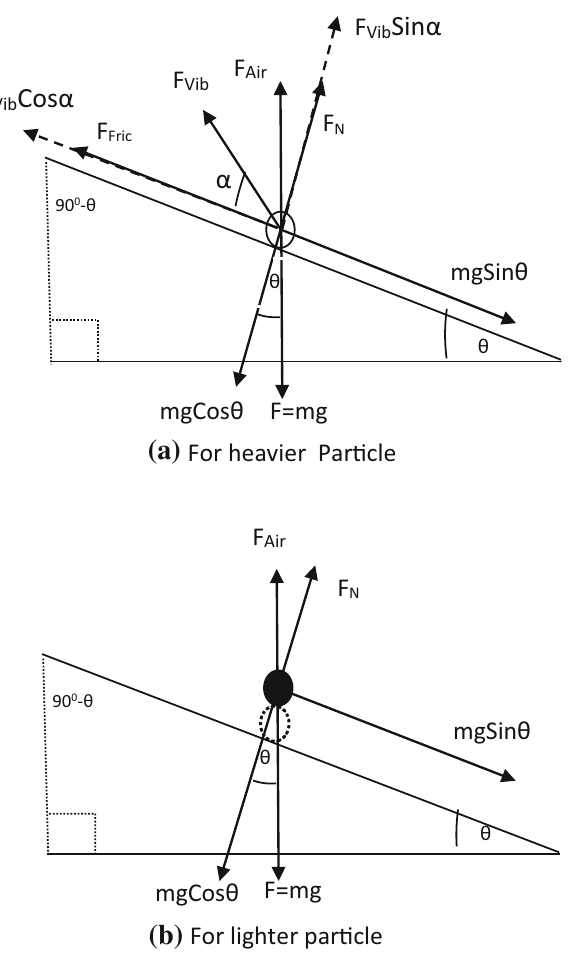
Fig. 7 Forces acting on the particles on the moving table